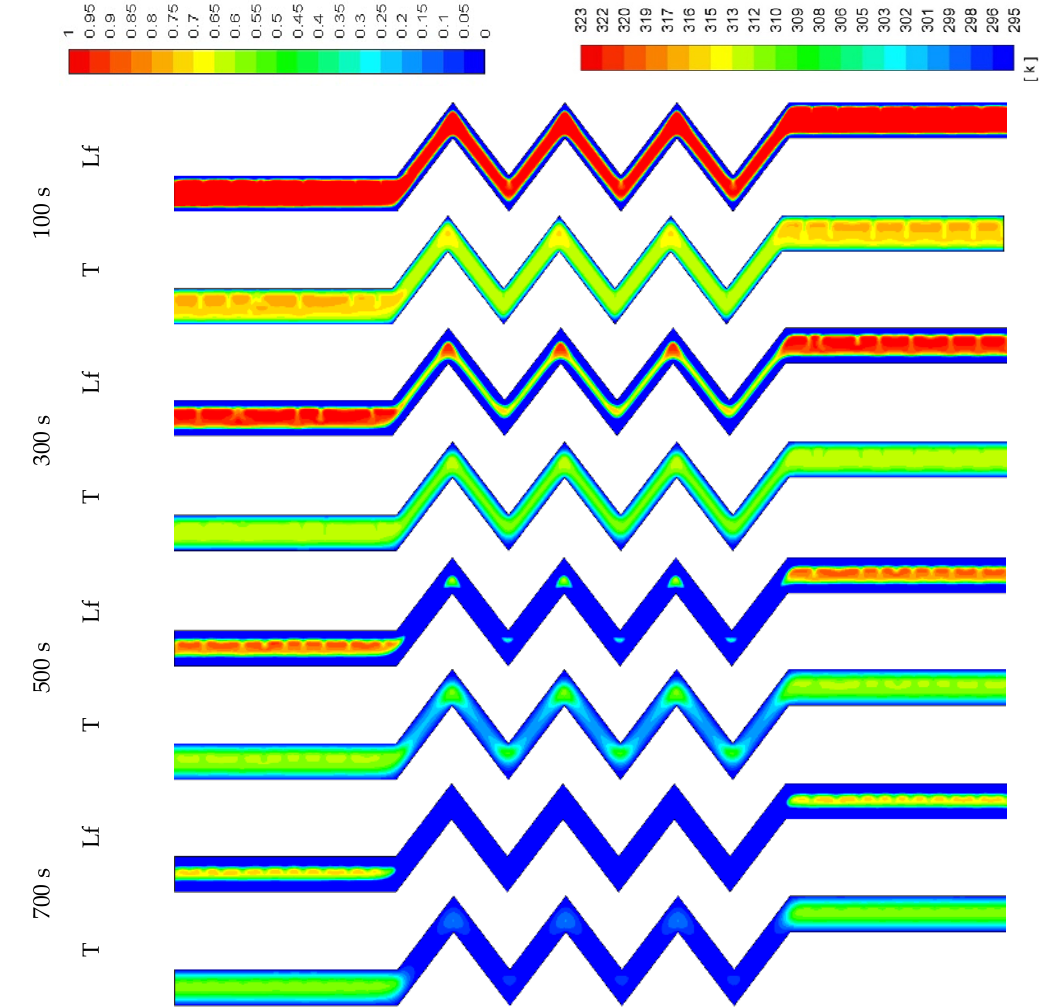
Figure 20. Contours of the liquid-fraction and temperature in a solidification process for the double width (2 W) horizontal corrugated